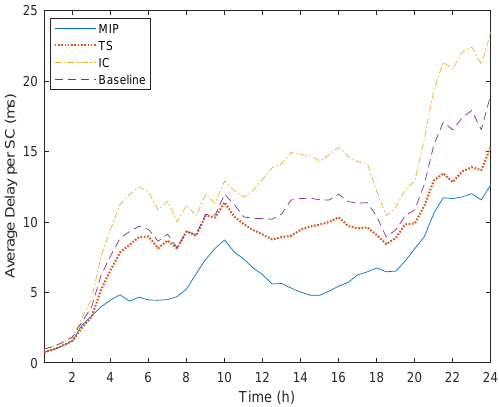
Figure 13. Total average delay per service